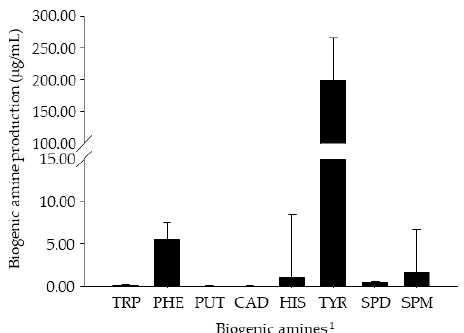
Figure 1. Biogenic amine (BA) production by Enterococcus strains (n = 169) isolated from retail Cheonggukjang products. Error bars indicate standard deviations calculated from duplicate experiments. 1 TRP: tryptamine, PHE: β -phenylethylamine, PUT: putrescine, CAD: cadaverine, HIS: histamine, TYR: tyramine, SPD: spermidine, SPM: spermine.